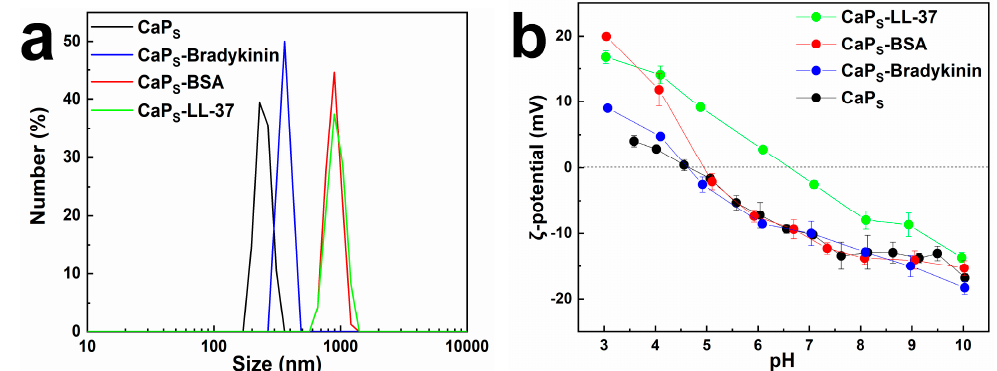
Figure 5. ( a ) Size distribution of CaP S nanoparticles (number % data) before and after loading with BSA, bradykinin and LL-37 in phosphate-buffered saline (PBS) pH 7.4, as determined by dynamic light scattering (DLS) measurements (particle concentration 100 μ g/mL); ( b ) ζ - potential profile of CaP S and loaded CaP S particles as determined by titration at different pH (particle concentration 100 μ g/mL).